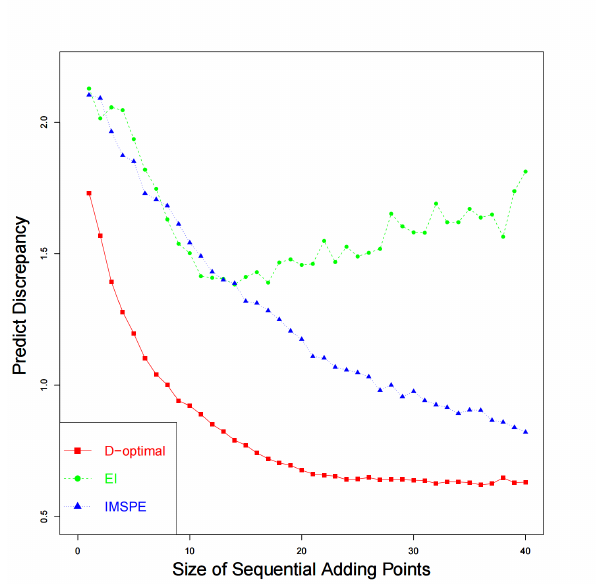
Figure 6. MPD l obtained using the proposed sequential D-optimal method, EI method, and IM- SPE method.